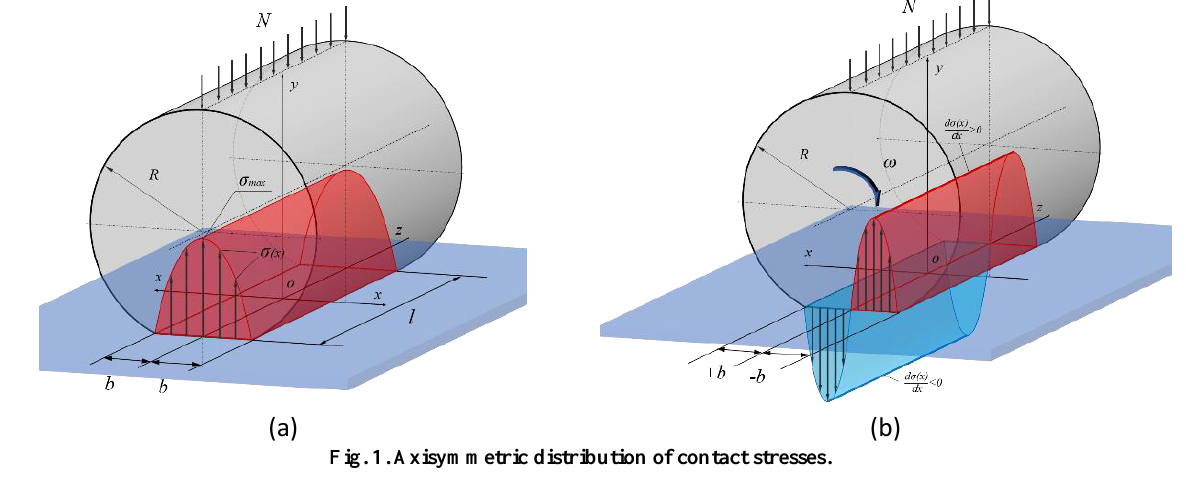
Fig. 1. Axisymmetric distribution of contact